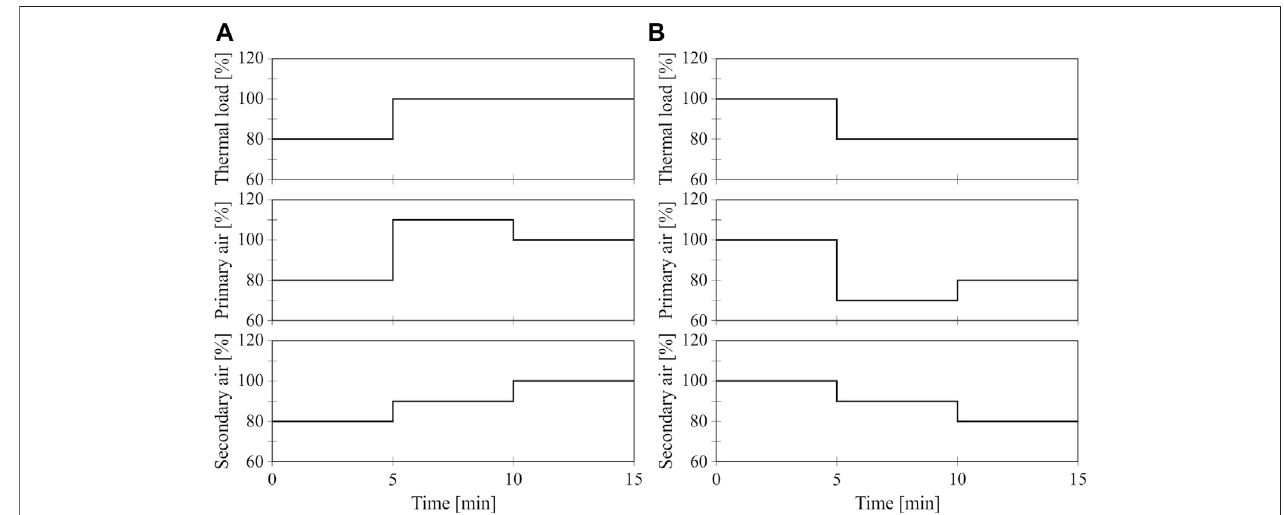
FIGURE 12 | Concept of boosted hydrodynamics. (A) Load increase (B) Load decrease.